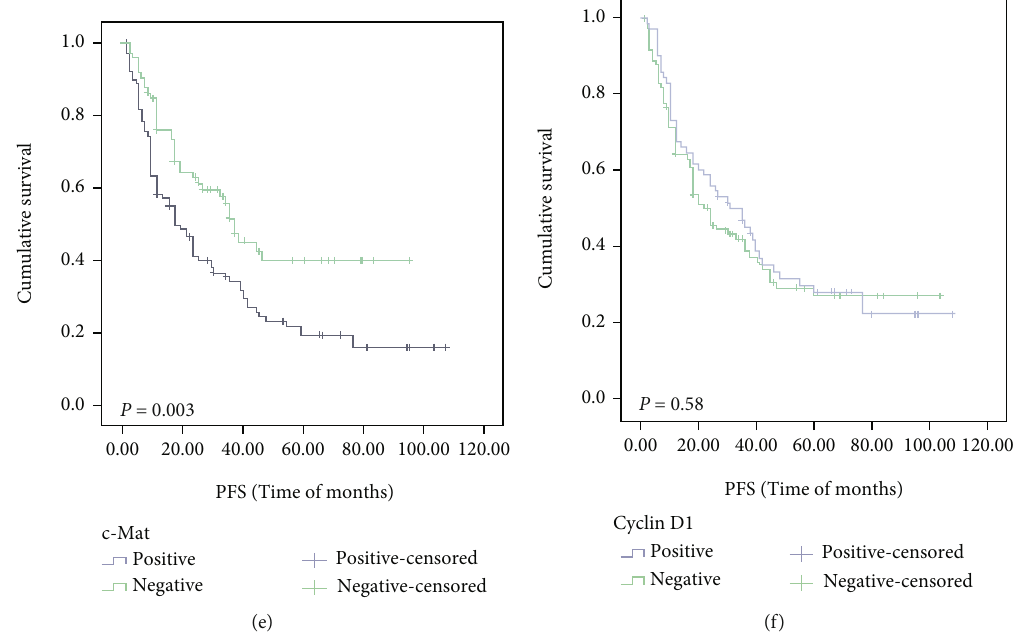
Figure 4: OS and PFS analysis of patients MACC1, c-Met, and cyclin D1 expression with ESCC using the Kaplan – Meier method. Notes: OS according to (a) MACC1 expression ( P = 0 : 008 ), (b) c-Met expression ( P < 0 : 001 ), and (c) cyclin D1 expression ( P = 0 : 74 ). PFS according to (d) MACC1 expression ( P = 0 : 17 ), (e) c-Met expression ( P = 0 : 003 ), and (f) cyclin D1 expression ( P = 0 : 58 ). Abbreviations: OS: overall survival; PFS: progression-free survival; ESCC: esophageal squamous cell carcinoma. Table 7: Multivariate analysis of factors associated with OS and PFS for